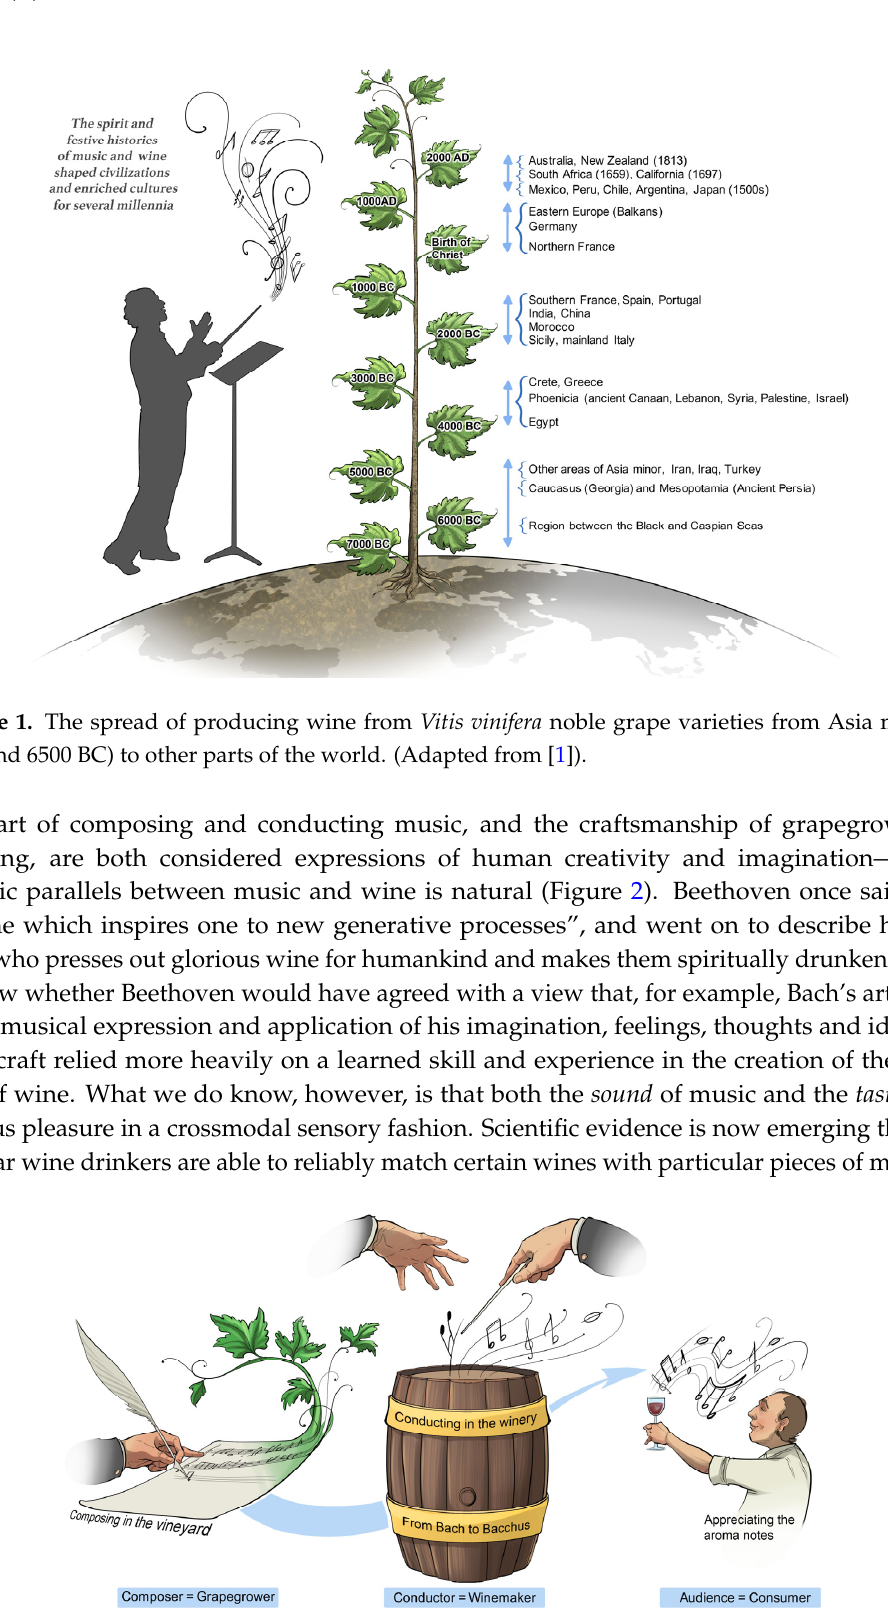
Figure 2. A metaphoric parallel between music and wine as expressions of human creativity and imagination. The grapegrower composes the notes of wine in the vineyard while the winemaker interprets and conducts the original composition with his instruments of choice in the winery with the sole aim to meet the expectations of his audience in a specifically ‐ targetted consumer market.